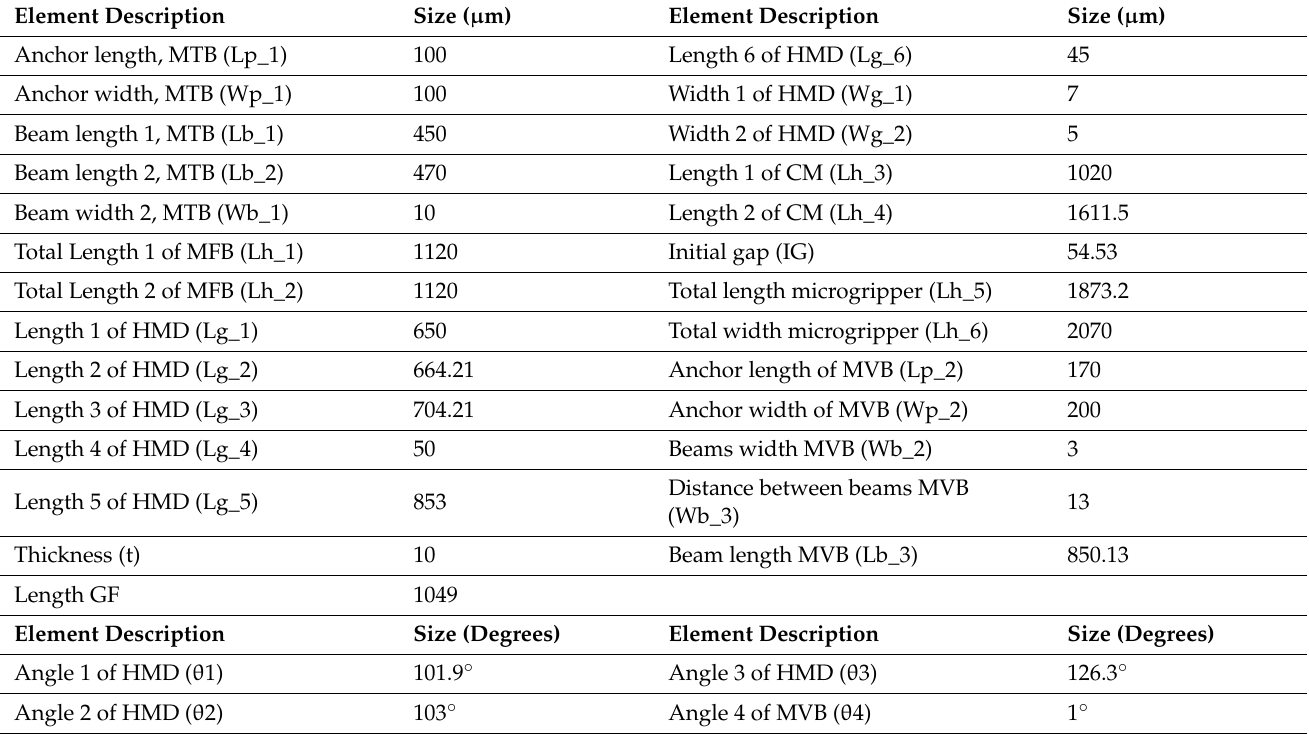
Table 2. Geometrical parameters of the microgrippers’ designs (Model 1 and